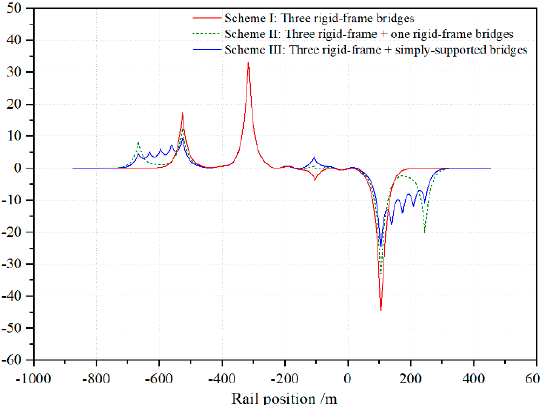
Figure 19. Additional braking forces of the rail for three different schemes.